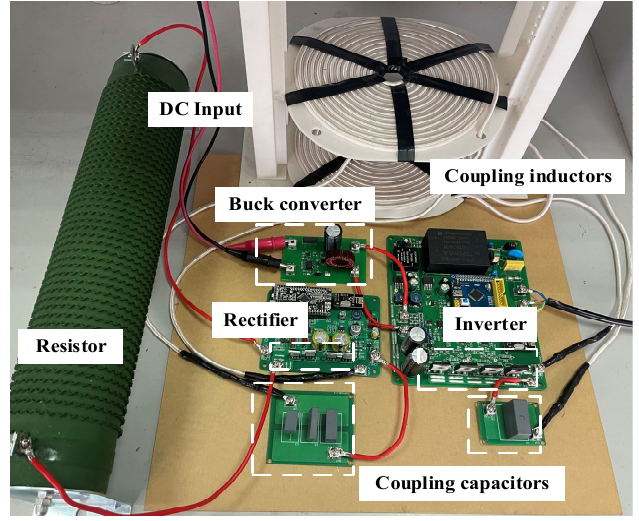
Figure 11. Prototype of the proposed CC&OV-PT controlled two-stage WPT system.